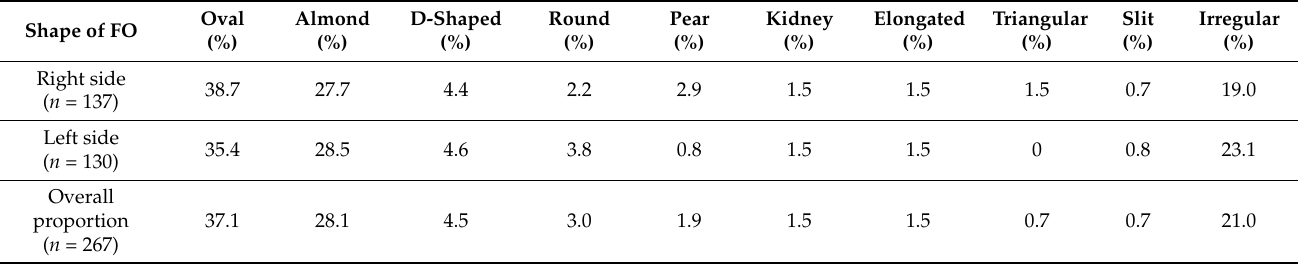
Table 2. Distribution of foramen ovale